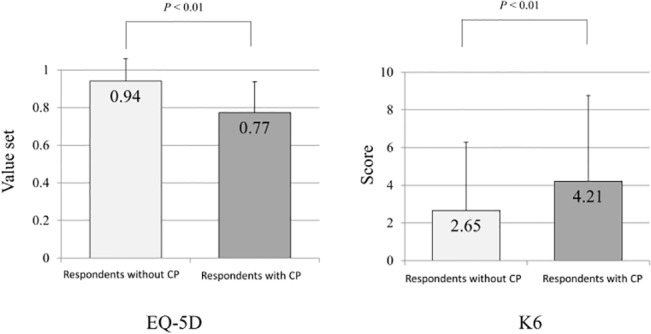
Influence of chronic pain on health-related quality of life and psychological distress.Statistical analysis undertaken with independent t test; mean values are shown within the columns, error bars represent standard deviation.